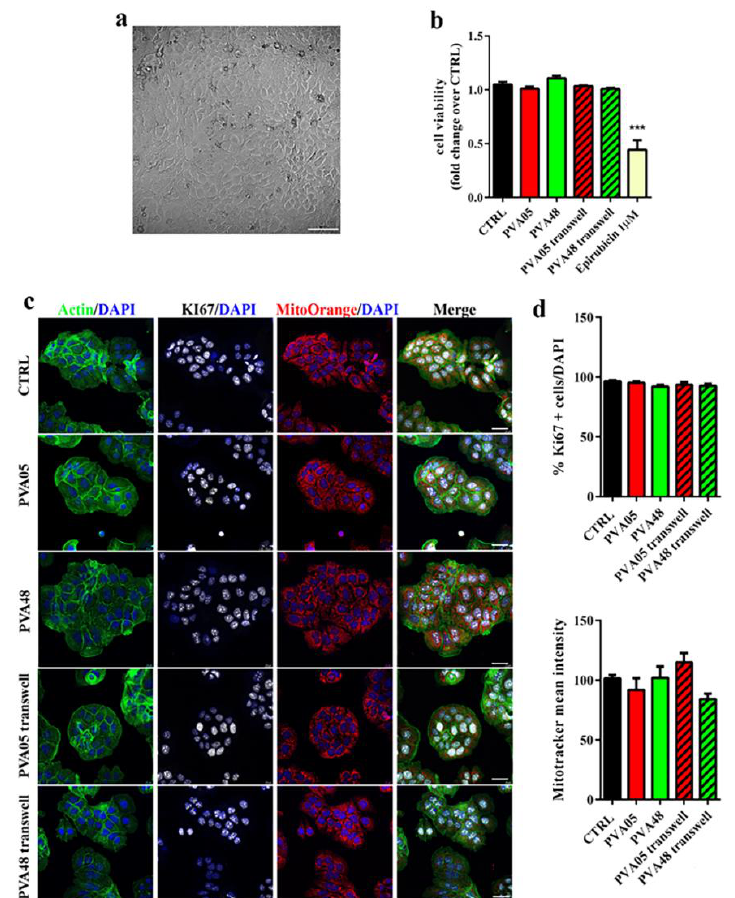
Figure 3. Cytotoxicity evaluation of uncoated PVA05- and PV48-based specimens. ( a ) Brightfield microscopy image of HT1376 cells (100 µm scale bar); ( b ) cell viability of HT1376 cells exposed to different samples for 24 h ( n = 6). Untreated cells (CTRL) and epiribicin-treated cells were used as negative and positive controls, respectively (*** p < 0.0001 versus CTRL); ( c ) confocal microscope images of HT1376 cells stained with phalloidin to detect actin (green), Ki67 (white), Mitotracker Orange (red) and DAPI (blue) (20 µm scale bar); ( d ) upper panel: graph of the % of Ki67+ cells over total cells counted by DAPI staining; bottom panel: graph of the mean fluorescent intensity of Mitotracker Orange ( n = 3).